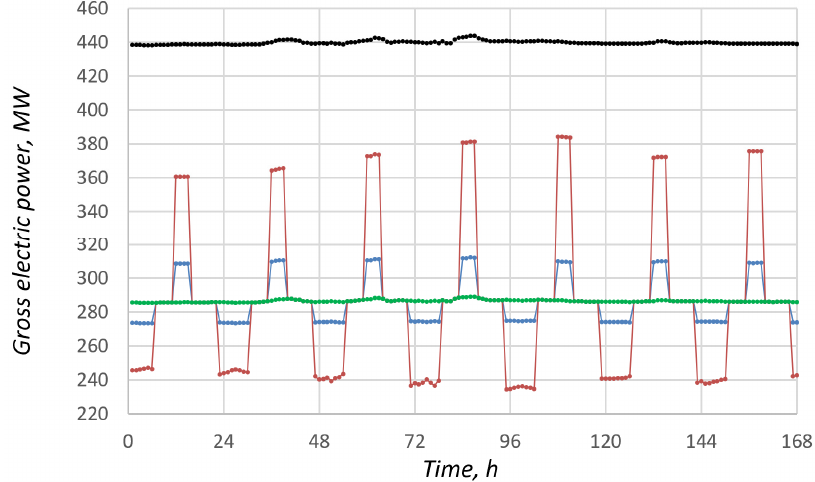
Figure 10. Gross electric power as a function of time for first week of reference year (black—REF_3NR, green—REF_2NR, blue—TES25 (200 MWh), and red—TES150 (1200 MWh)).